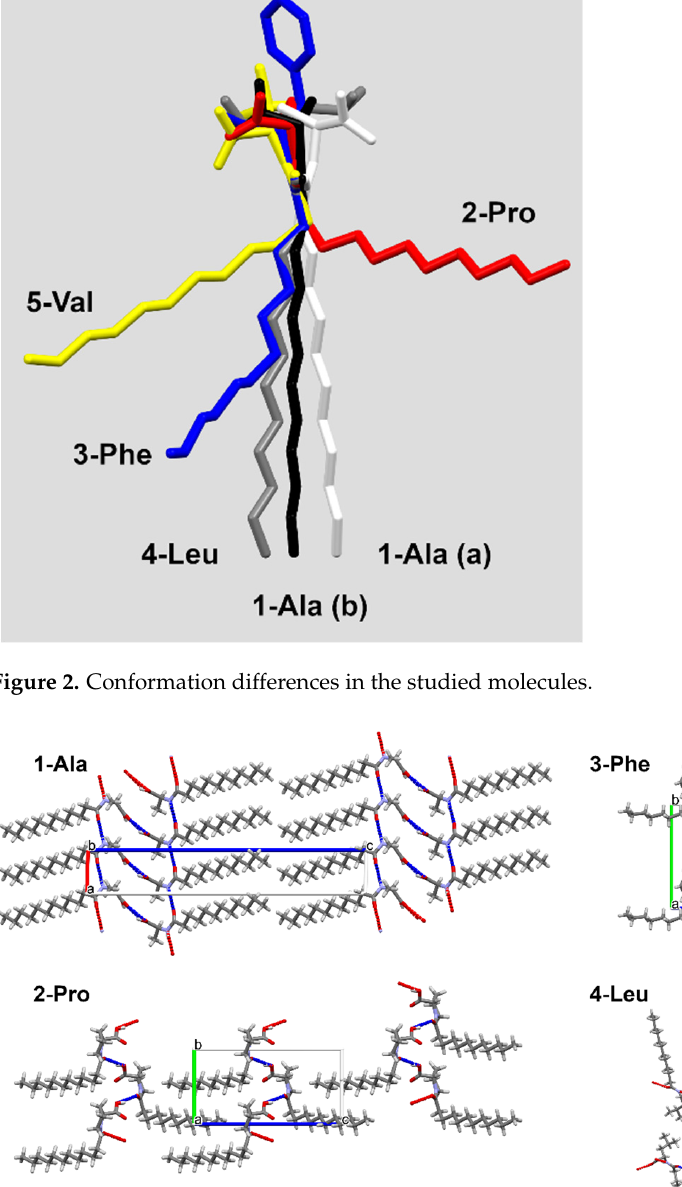
Figure 3. Crystal packing in structures of 1-Ala, 2-Pro, 3-Phe, 4-Leu, 5-Val. Table 1 contains the pairwise interaction energies for the analyzed crystals calculated using the CrystalExplorer at CE-B3LYP/6-31G(d,p) level in kJ/mol. All of the values were scaled by factors 1.057, 0.74, 0.871, and 0.618 for coulombic, polarization, dispersion, and repulsion energy terms, respectively, according to Mackenzie et al. [37].